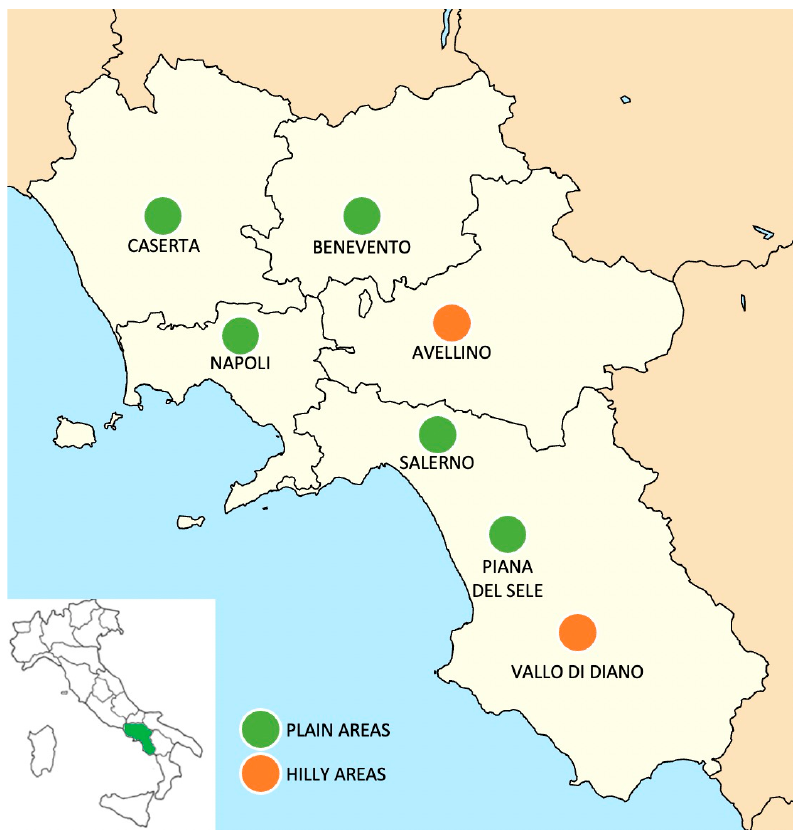
Figure 1. Geographical map of the different sampling sites.